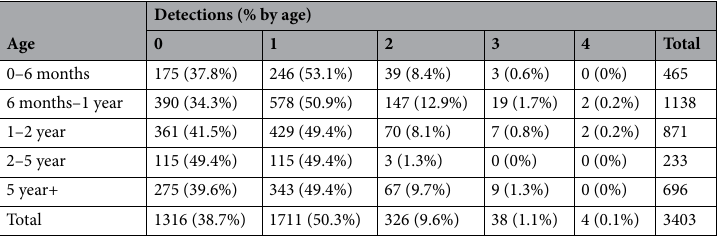
Table 1. Numbers of virus detections by age. Table gives the numbers of virus detections (0–4) by age for the study population. Percents are percents of age class by number of detection, ie, 175 of 465 0–6 month olds (37.8%) had 0